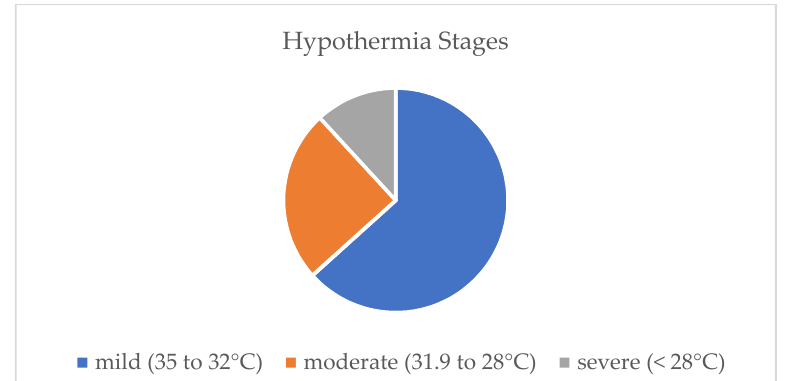
Figure 1. Flow diagram.